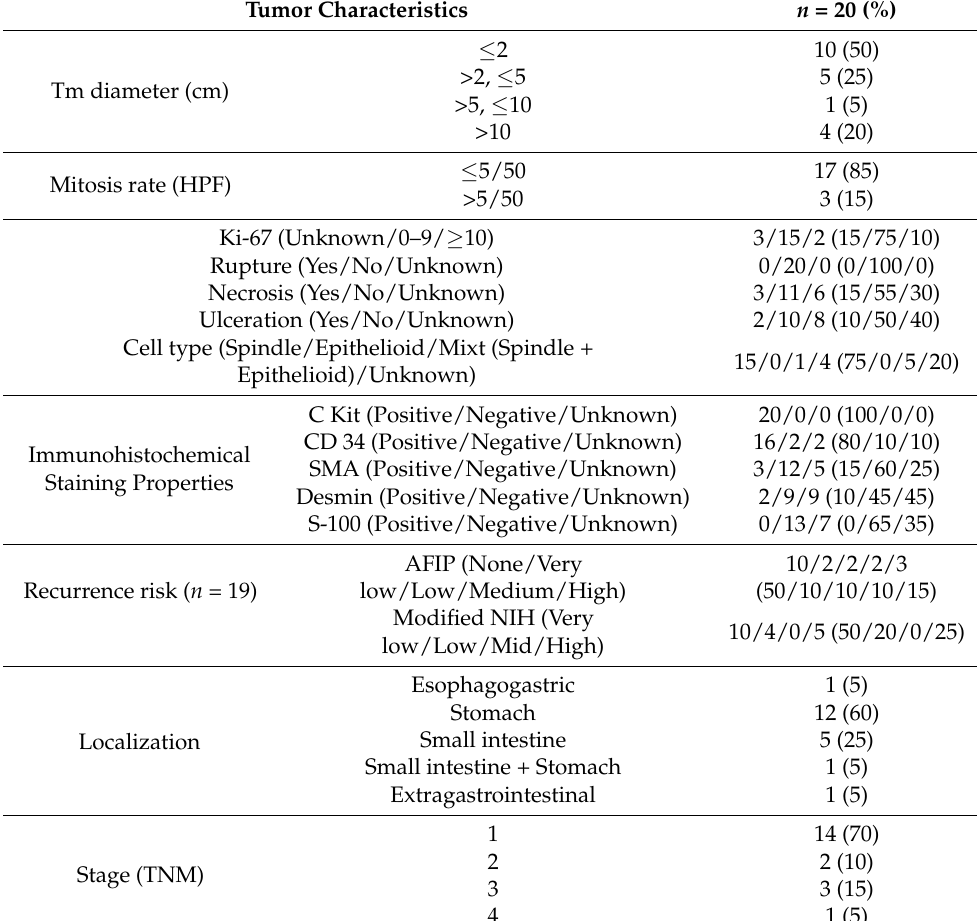
Table 2. Pathological features of gastrointestinal stromal